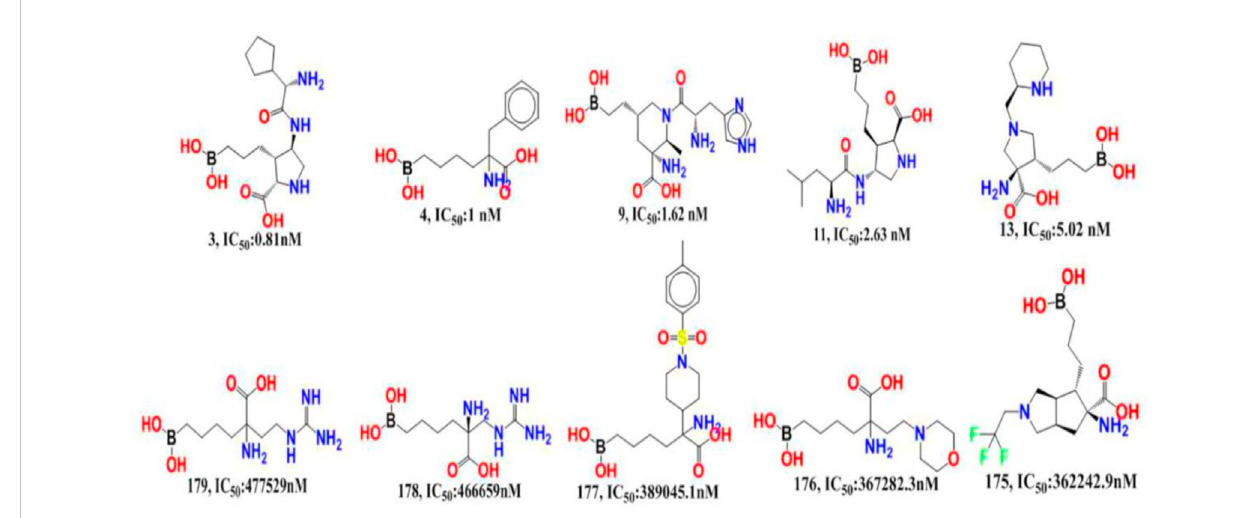
FIGURE 2 Depiction of the chemical structures for the fi ve most active and fi ve least active Arginase I inhibitors from the present